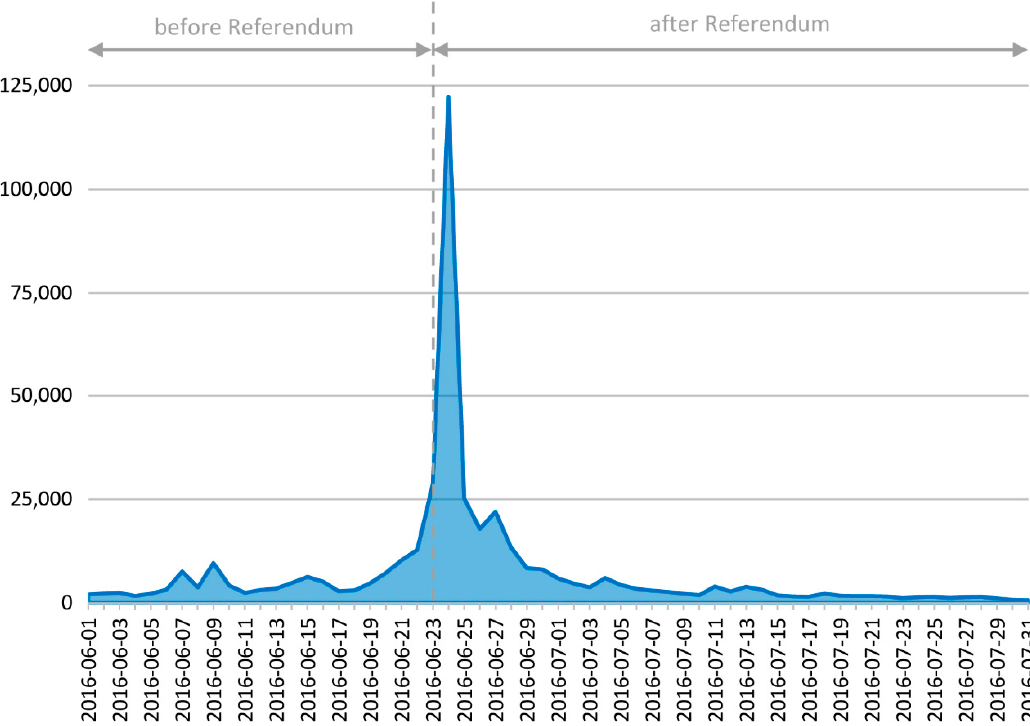
Figure 1. Georeferenced and non-georeferenced tweets for 23 June 2016 and 24 June 2016.